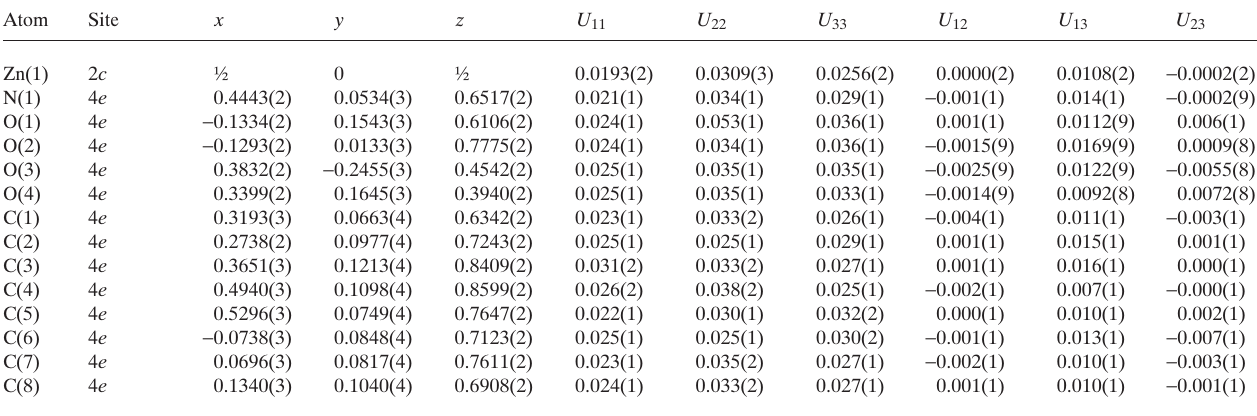
Table 3. Atomic coordinates and displacement parameters (in Å 2 )